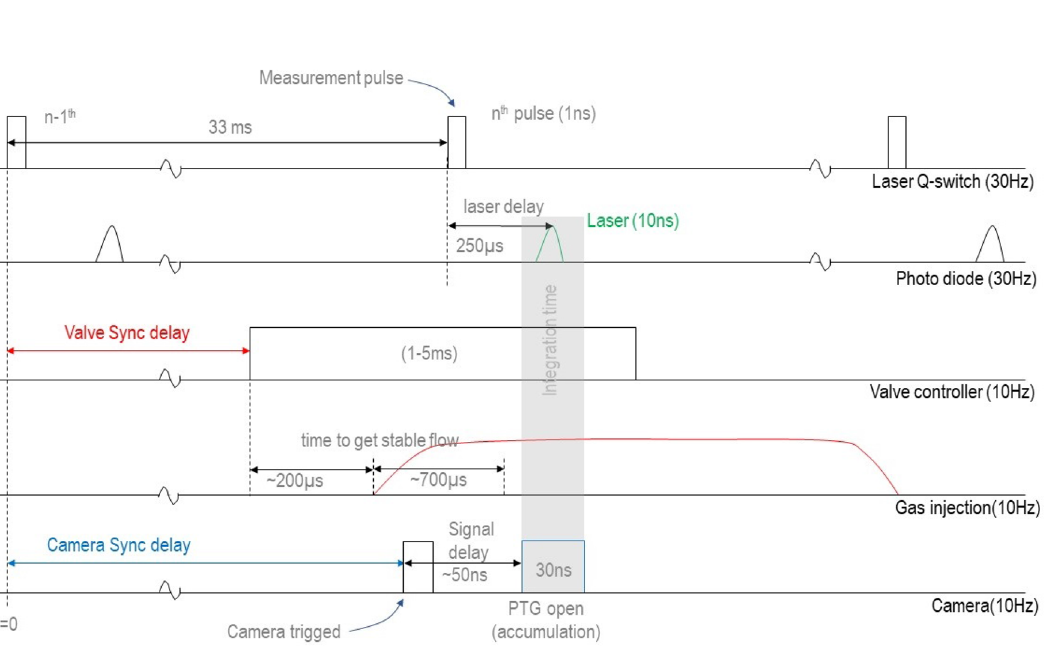
Figure 2. Timing diagram showing synchronization of laser and camera with gas